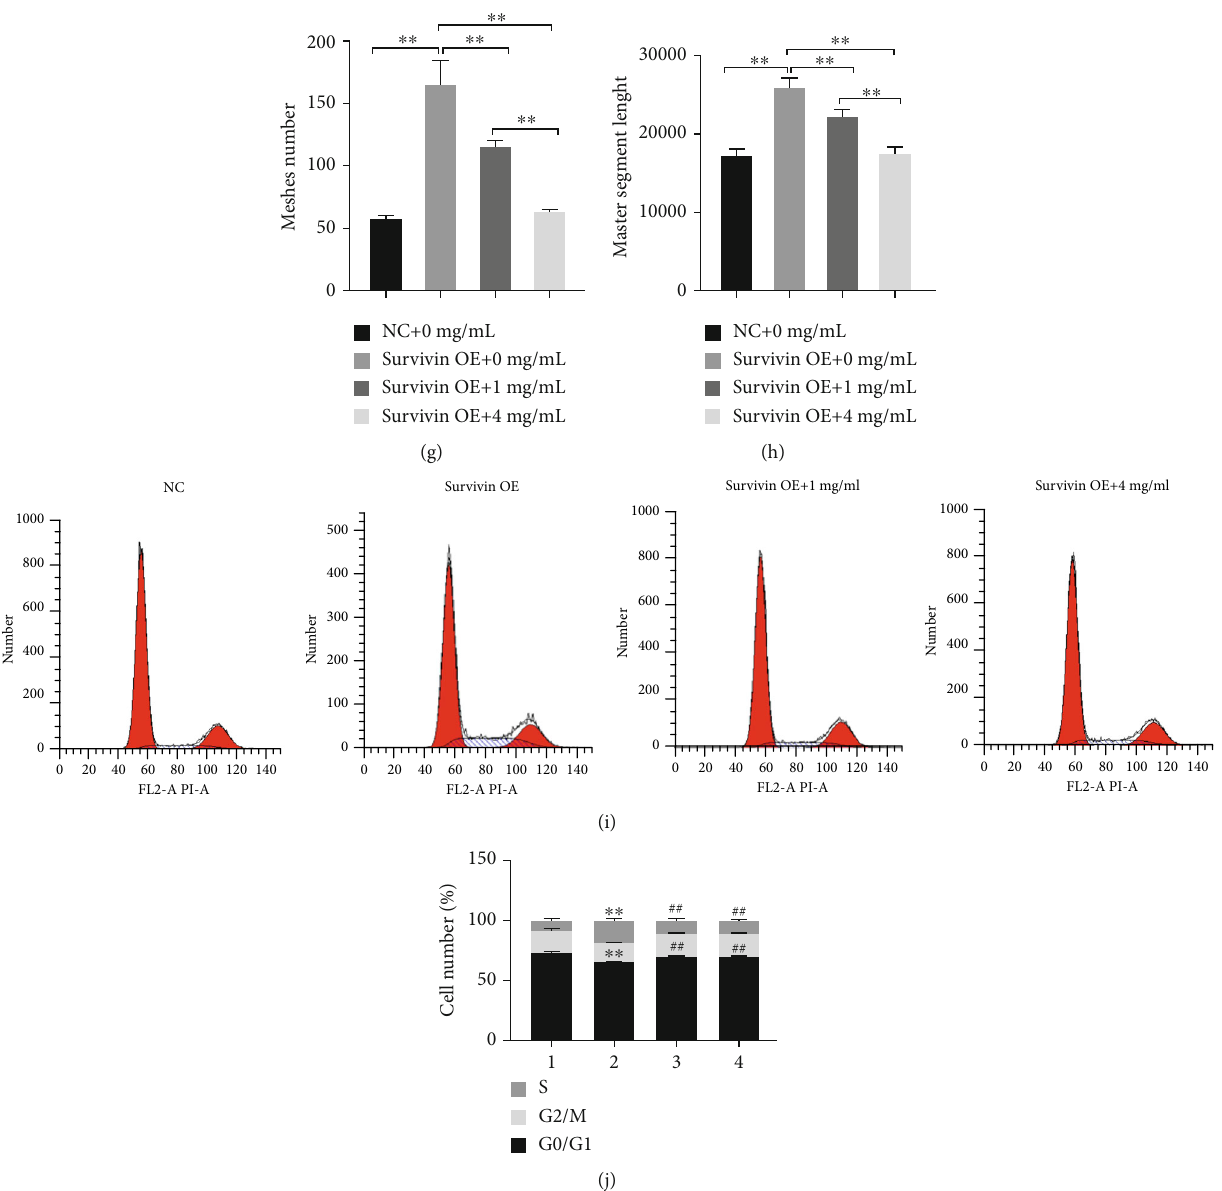
Figure 7: The e ff ect of YXJD on HUVEC cells induced by Survivin and its molecular mechanism HUVEC cells transfected with Survivin overexpressed plasmid were treated with di ff erent concentrations of YXJD (0, 1, and 4 mg/mL) for 24 h by CKK-8 detection (a). The induction of apoptosis was determined by annexin V – FITC/PI staining assay (b, c). Transwell: the e ff ect of di ff erent concentrations of YXJD (0, 1, and 4mg/mL) on the migration ability of HUVEC cells transfected with Survivin overexpression plasmid (d). Statistical chart: ordinate: number of cells (e). Tube formation detection was used to detect the e ff ects of di ff erent concentrations of YXJD on the angiogenic ability of HUVEC cells transfected with Survivin overexpression plasmid (f). Meshes number (g) and master segments length (h). Statistical chart: ordinate: number of lumen/length of lumen. Magni fi cation: 100 × (f – h). Flow cytometry cell detected cycle distribution of HUVEC cells transfected with Survivin overexpression plasmid with di ff erent concentrations of YXJD (i). Statistical chart: ordinate: cell number